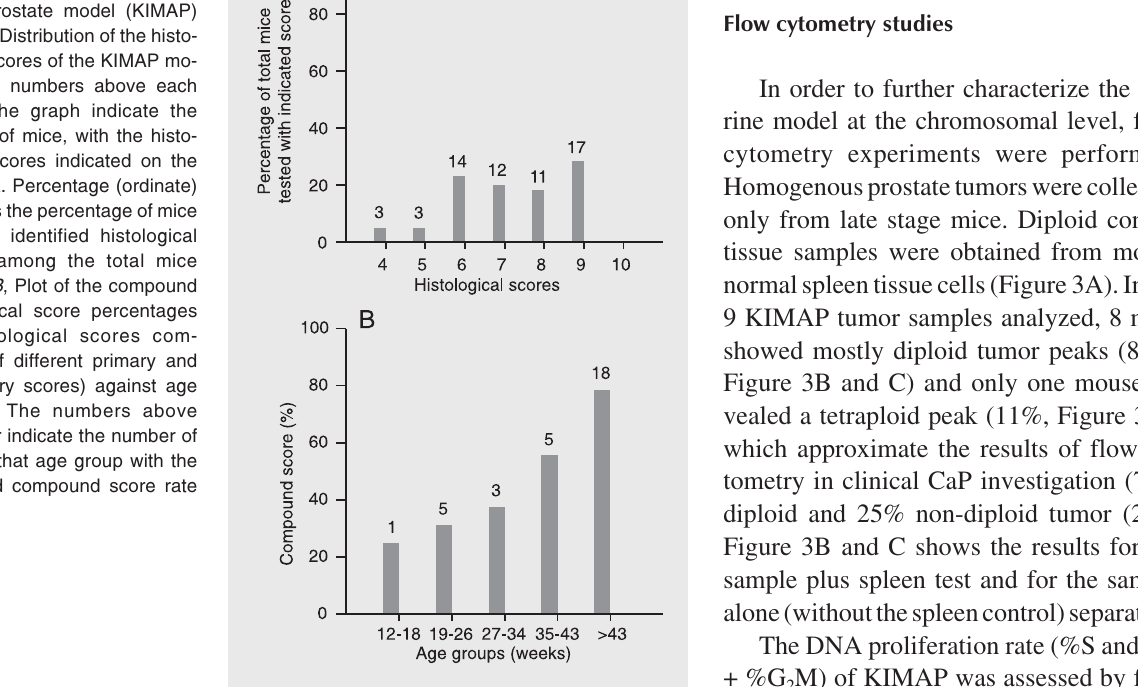
Figure 2. Histological scores (compound score percentage) for knock-in mouse adenocarci- noma prostate model (KIMAP) mice. A , Distribution of the histo- logical scores of the KIMAP mo- del. The numbers above each bar in the graph indicate the number of mice, with the histo- logical scores indicated on the abscissa. Percentage (ordinate) indicates the percentage of mice with the identified histological scores among the total mice tested. B , Plot of the compound histological score percentages (% histological scores com- posed of different primary and secondary scores) against age groups. The numbers above each bar indicate the number of mice of that age group with the identified compound score rate